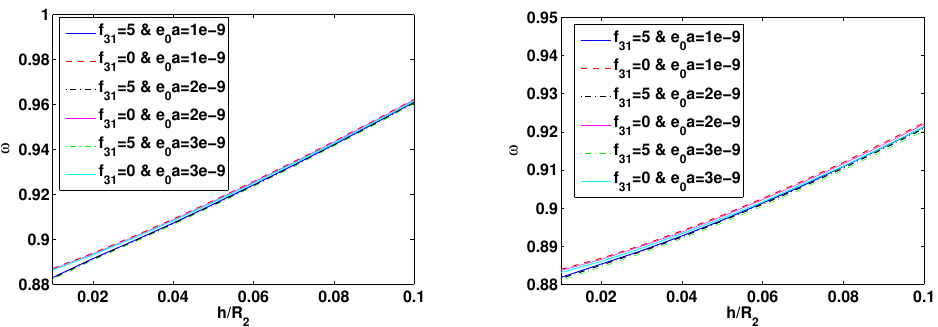
Figure 3. The effect of the flexoelectric term and nonlocal parameter on the frequency of FGM conical nanoshells ( α = 30, p = 1, k p = 1 × e − 3 , k w = 10 × e 12 , h p / h = 0.1, ( left ) clamped-clamped boundary conditions, ( right ) clamped-simply boundary conditions).